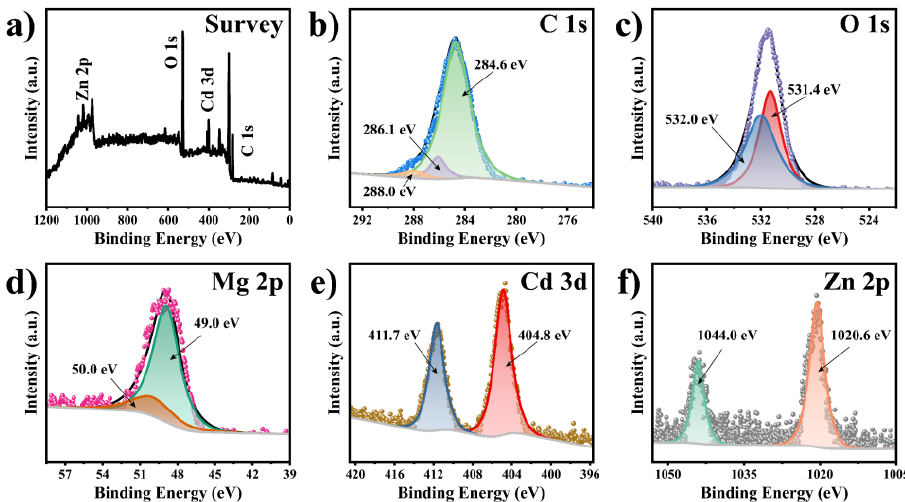
Figure 4. ( a ) XPS survey spectrum of MF@CdSe/ZnS NFs. ( b – f ) High-resolution XPS spectra of C 1s, O 1s, Mg 2p, Cd 3d, and Zn